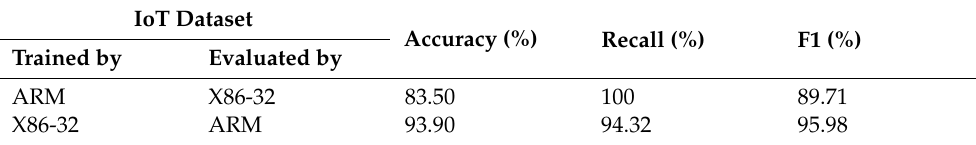
Table 3. Multi-type CPU architecture